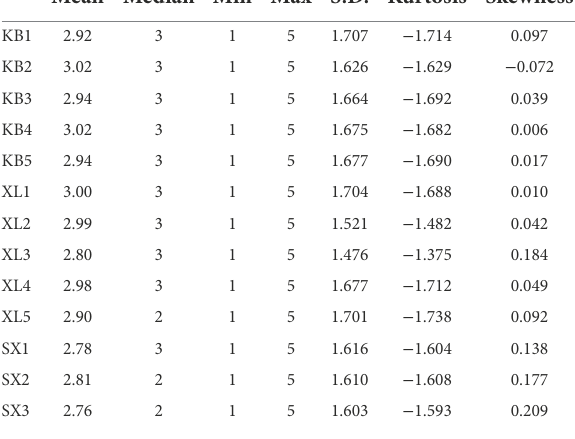
TABLE 1 Study 1: Descriptive statistical analysis of each